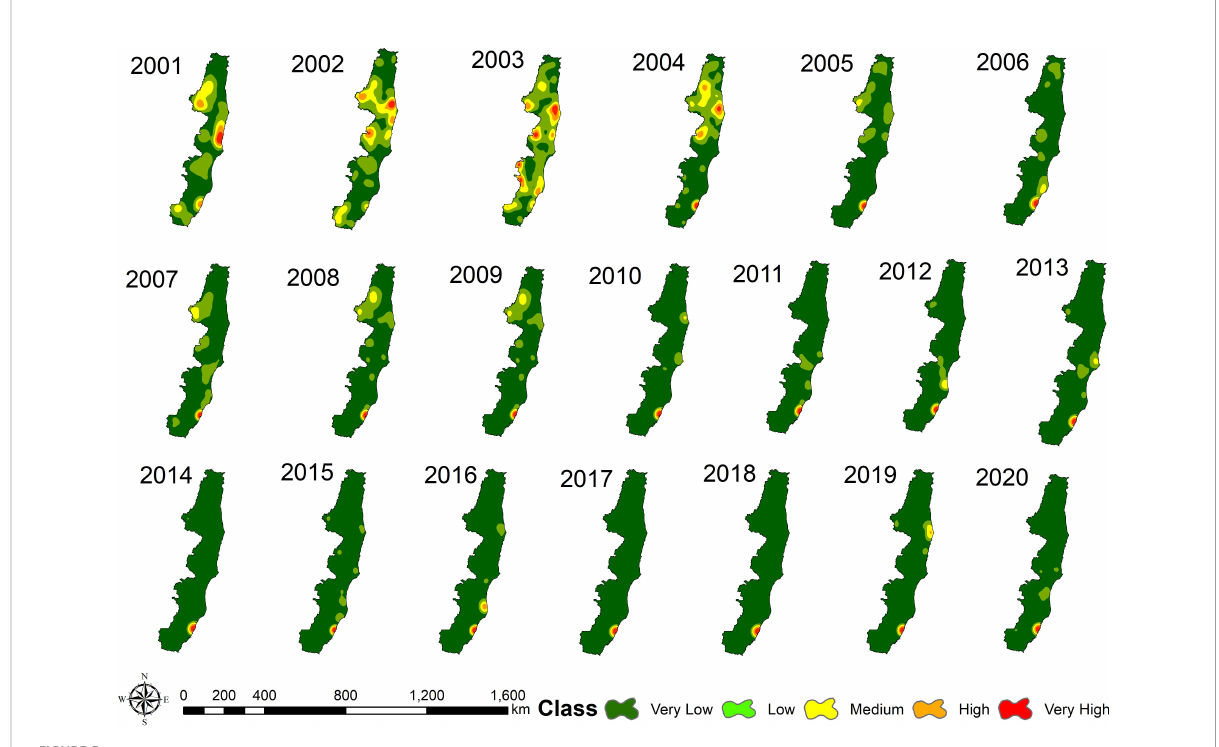
FIGURE 5 Kernel density of hotspots in the Central Atlantic Forest Corridor,